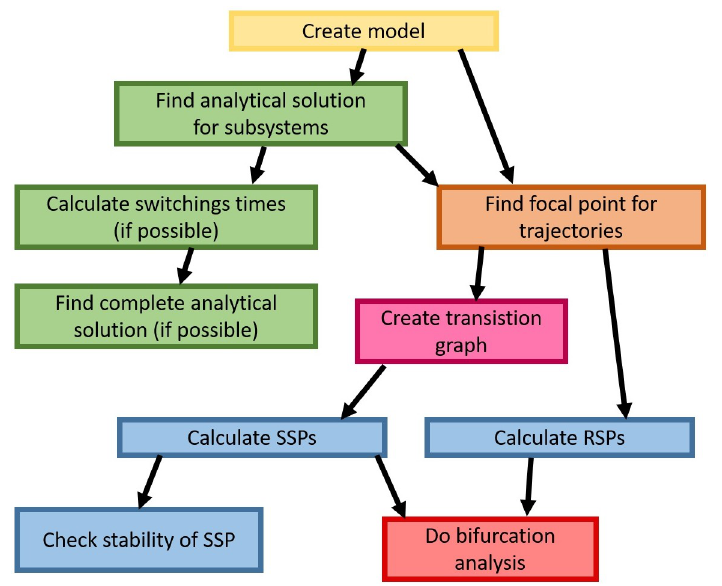
algorithm is to find an analytical solution for all subsystems. Usually, subsystems differ with respect to the model parameters, but not the structure, so the analytical solution for subsystems have the same formula with different parameter values. In some models, where the analytical formula is not very complicated, is possible to find times of switching with respect to the initial